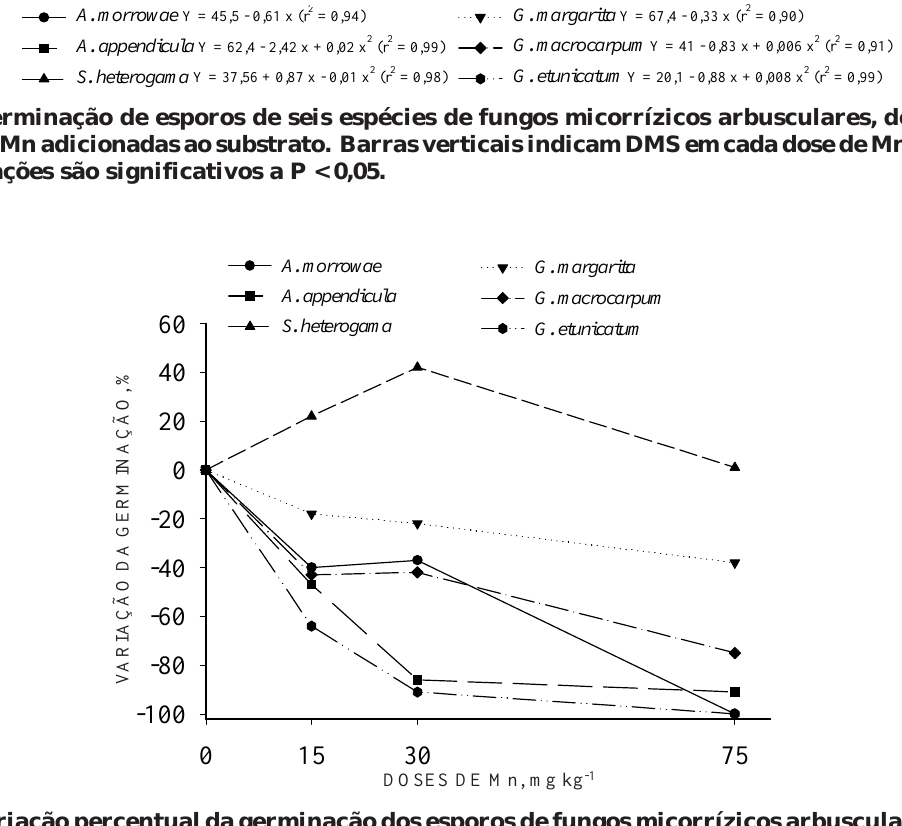
Figura 2. Variação percentual da germinação dos esporos de fungos micorrízicos arbusculares de acordo com doses de Mn adicionadas ao substrato, em relação ao tratamento sem adição de Mn.